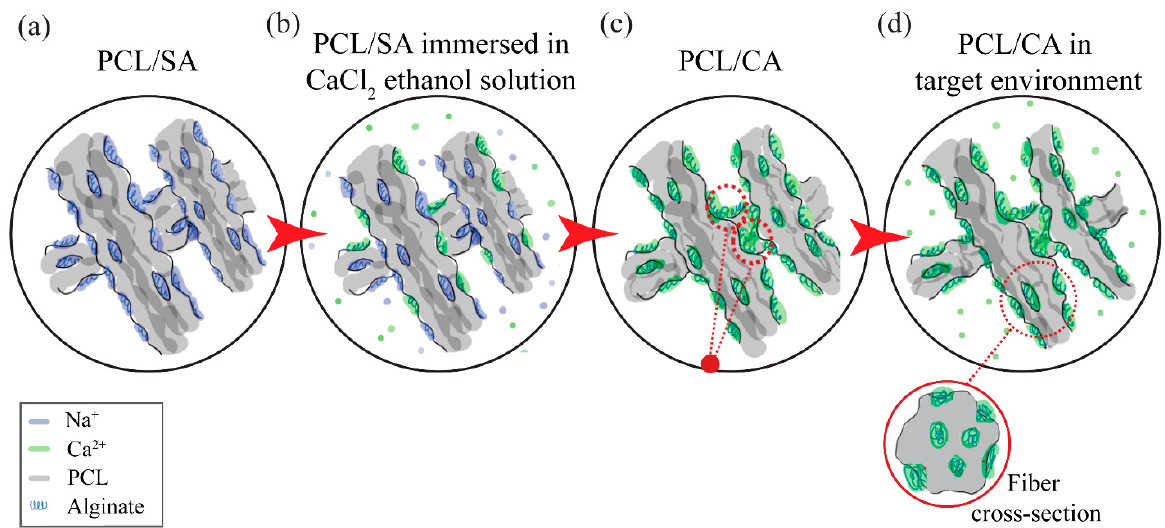
Figure 3. Schematic illustration of the leaching out process of the Ca 2+ ions. ( a ) As-fabricated PCL/SA scaffold, ( b ) scaffold immersion in a CaCl 2 ethanol solution triggers three different processes—calcium diffusion into the scaffold, sodium leaching out from the fibers, and calcium alginate acting as a crosslinker resulting in ( c ) a scaffold consisting of only PCL/CA fibers, which in the target environment ( d ) demonstrates Ca 2+ ion leaching out from its surface and the bulk of the fibers. The bottom and top surfaces of the control scaffolds displayed a mean fiber diameter of 2.57 and 1.72 µm, respectively, whereas the bottom and top surfaces of the crosslinked PCL/CA scaffolds exhibited thinner fibers with a mean diameter equal to 1.21 and 1.59 µm, respectively. The left insets of Figure 2 show the fiber diameter distributions. Statis- tical results of the fiber diameter at the bottom and top surfaces of the control and PCL/CA scaffolds are presented in Figure 4.